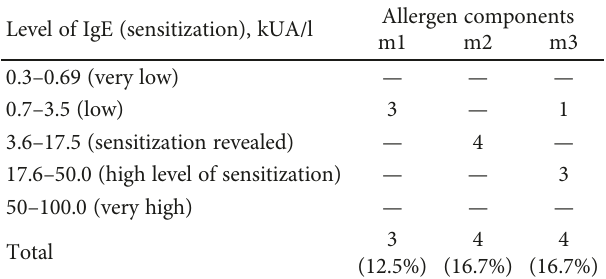
Table 5: Distribution of patients with seasonal allergic rhinitis according to the level of sensitization to allergen components of mold fungi ( N = 24 ).